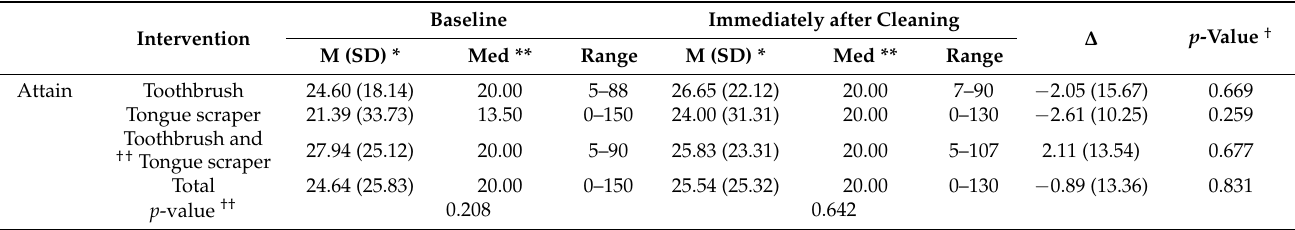
Table 11. Portable sulfide monitor score